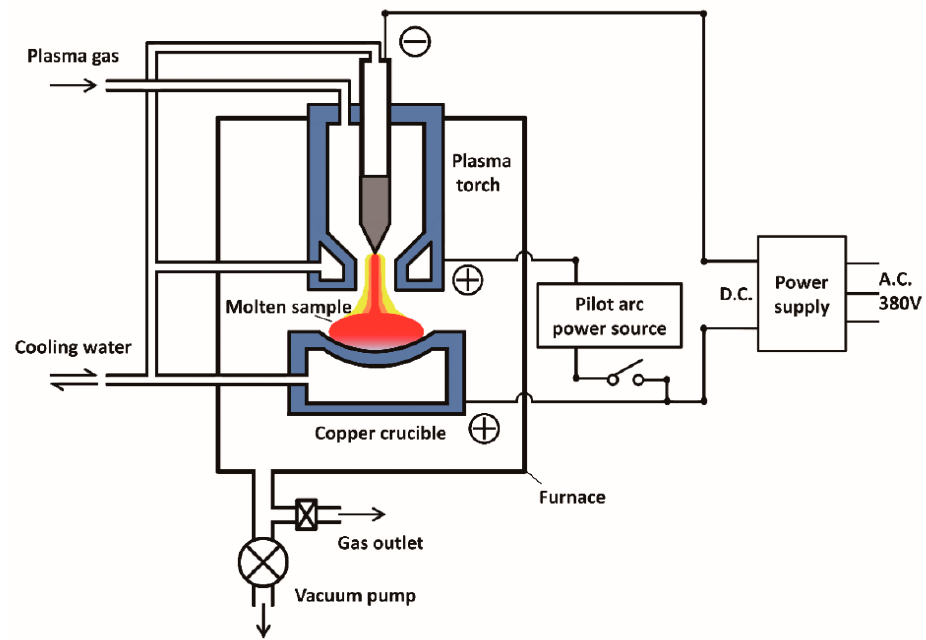
Figure 1 Schematic diagram of plasma arc furnace Figure 1. Schematic diagram of plasma arc